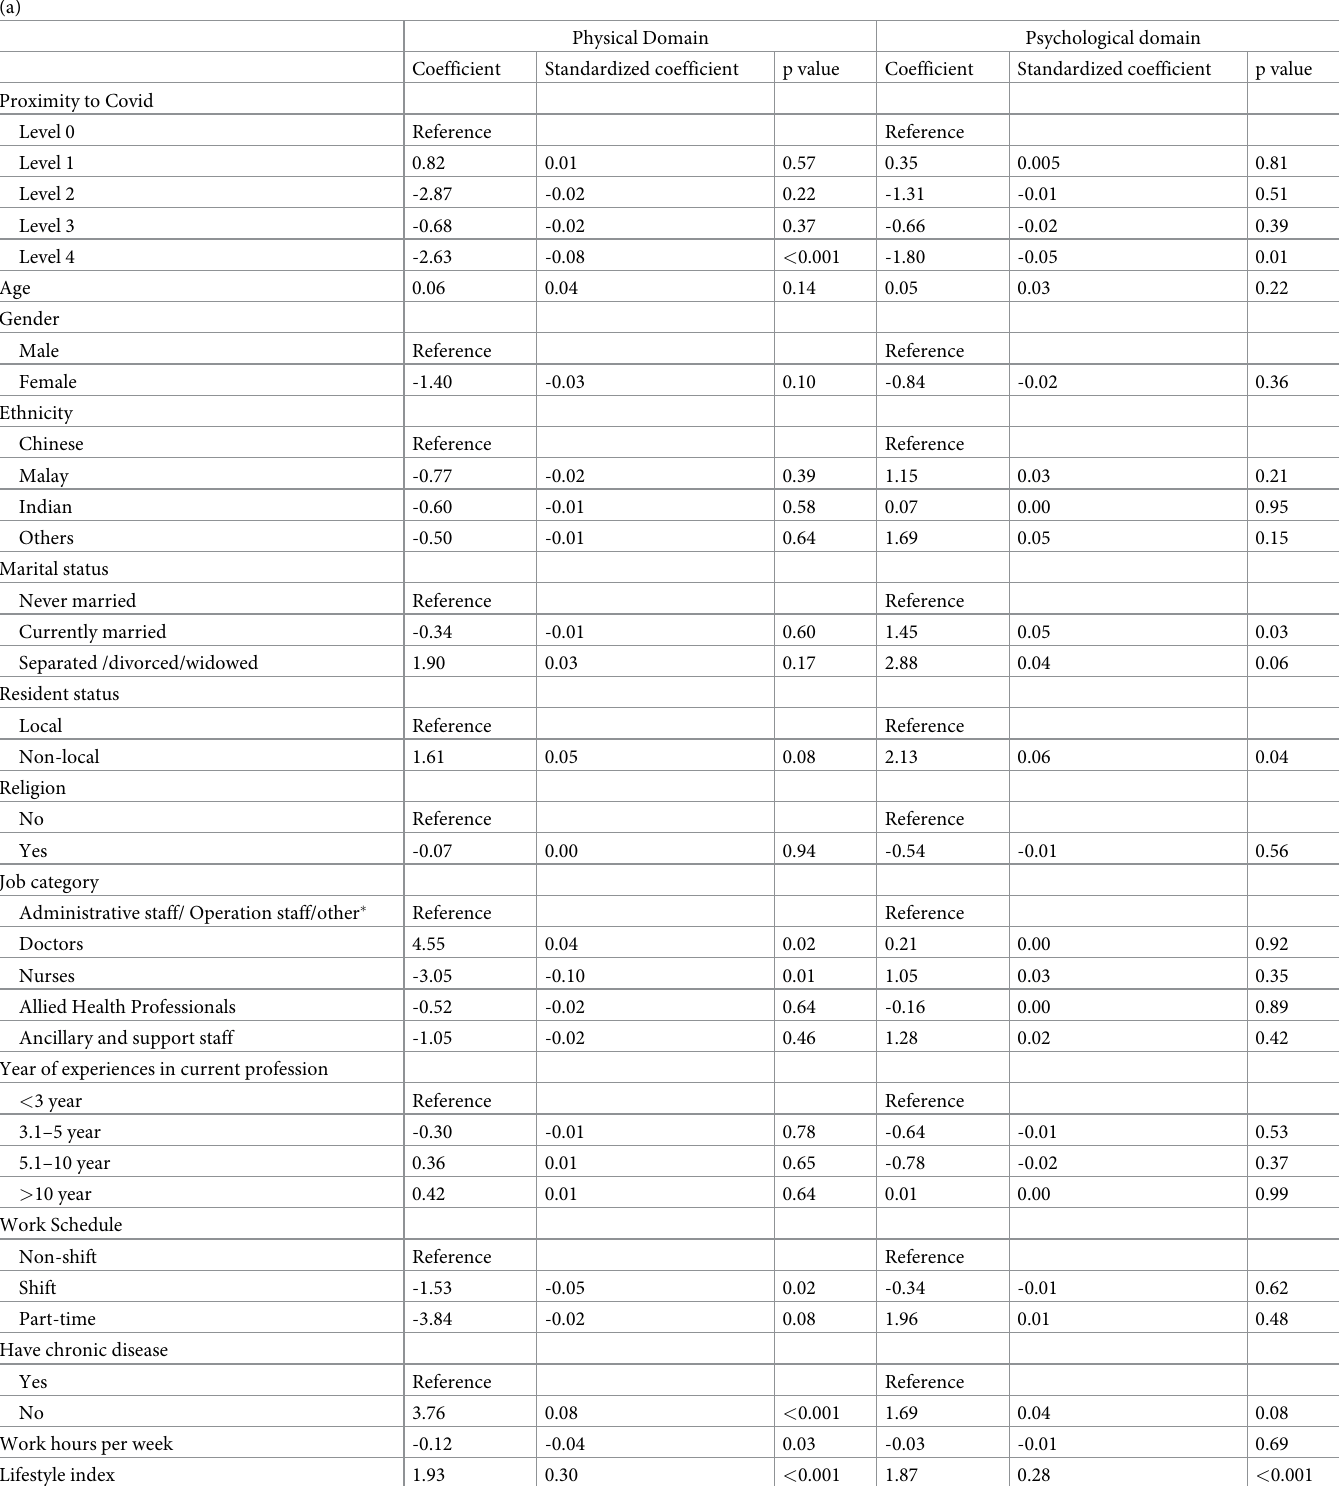
Table 3. Factors associated with quality of life (multivariate